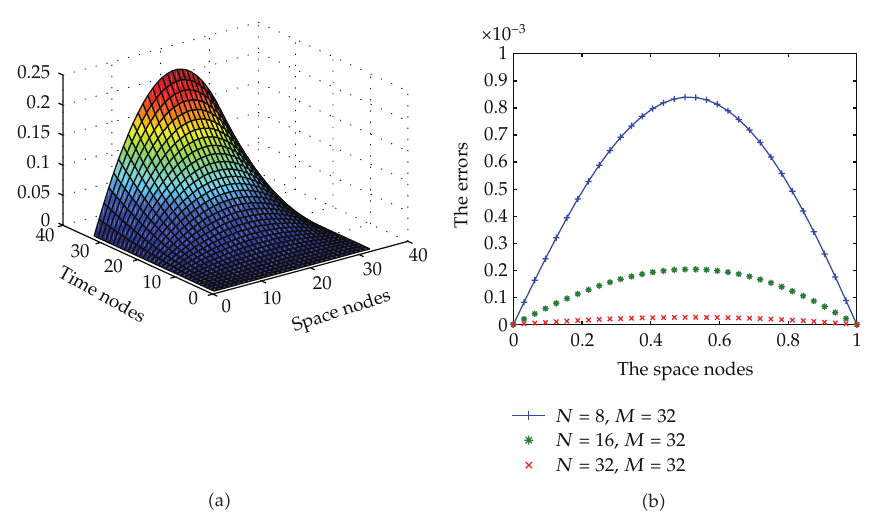
Figure 1: (cid:3) a (cid:5) The approximate solutions of Example 5.1 by the proposed method when N (cid:8) 32, M (cid:8) 32, and α (cid:8) 0 . 5. (cid:3) b (cid:5) The errors for some values of M and N when t (cid:8) 1 and α (cid:8) 0 . 5.